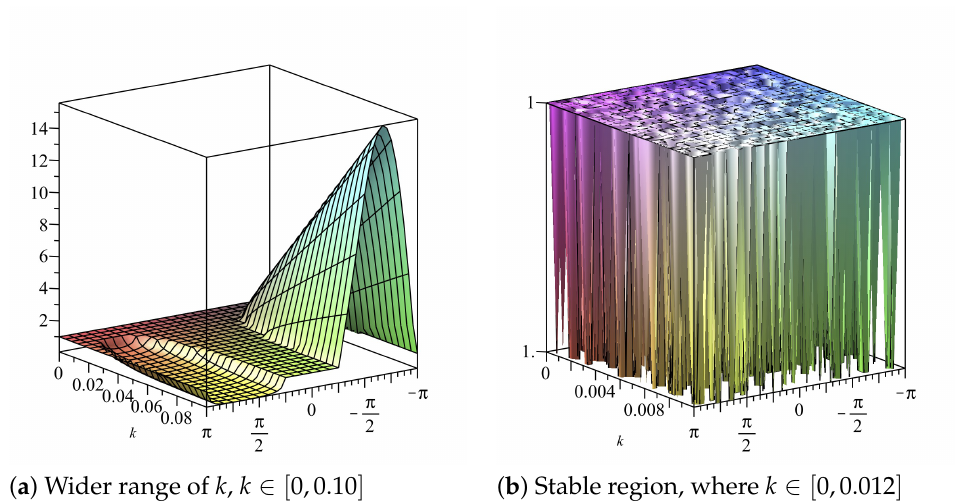
Figure 2. Plot of | ξ 2 | vs. k vs. w ∈ [ − π , π ] of Scheme 1 for Numerical Experiment 1. The spatial step size is h = π